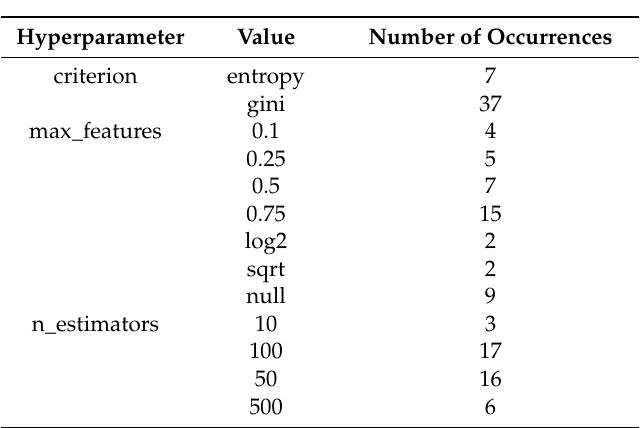
Table 5. The number of different values per Random Forest